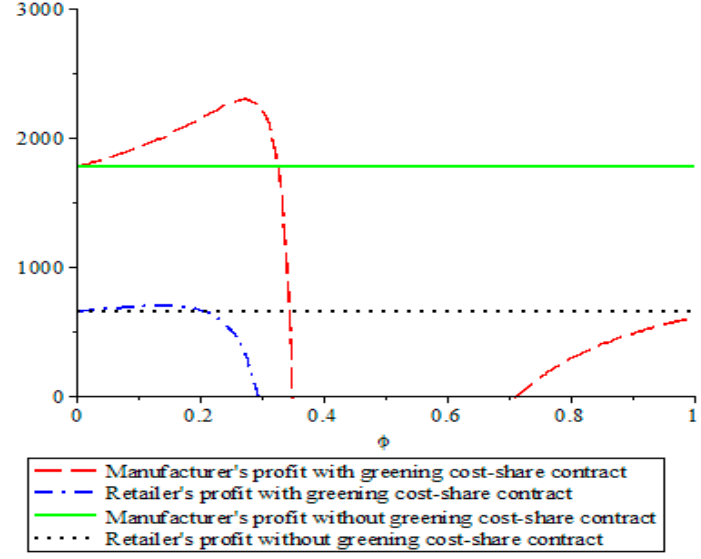
Figure 10. The impact of the proportion of greening cost on profits of manufacturer and retailer.